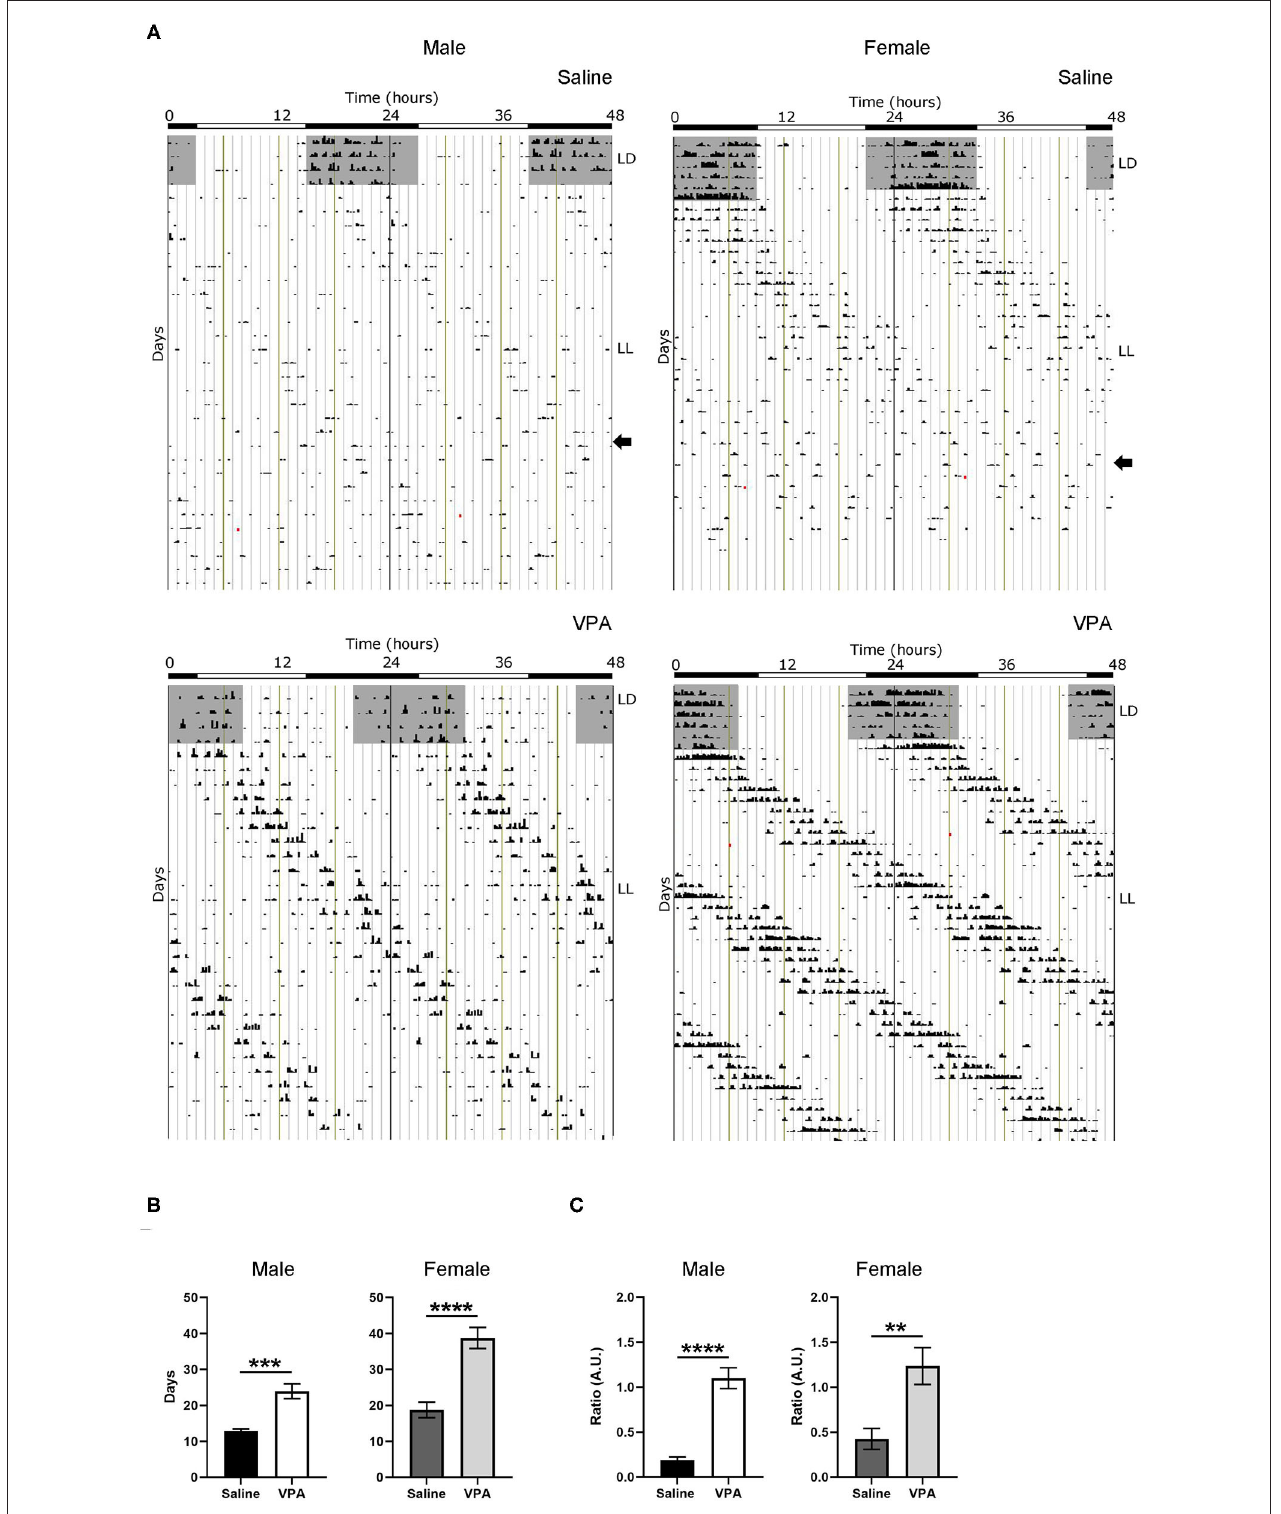
FIGURE 3 | In utero VPA exposure alters locomotor suppression under constant light (LL) conditions in both sexes. (A) Representative double-plotted actograms from (left panel) saline-exposed males and VPA-exposed males. Right panels represent double-plotted actograms from saline-exposed females and VPA-exposed